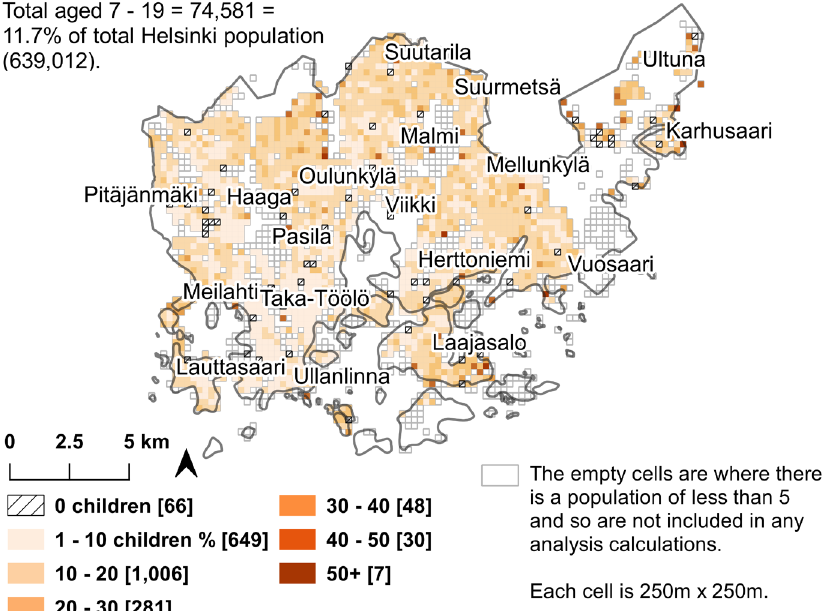
Fig. 2. Percentage of children and adolescents in